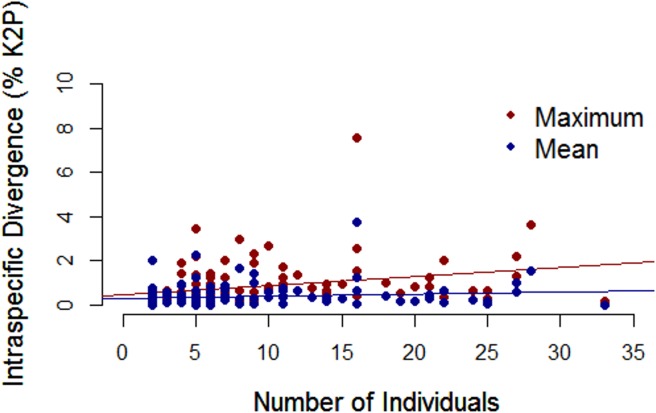
Relationship between COI distance and sample size.Maximum and mean intraspecific divergences (% K2P) plotted against the number of individuals sampled for 113 species. The regression between maximum intraspecific divergence and the number of individuals sampled is significant (R2 = 0.089, p<0.01).